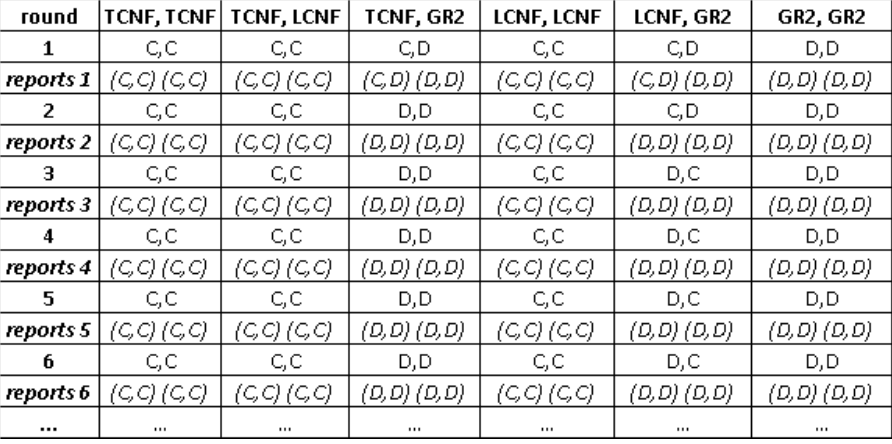
Patterns of interactions and reports for every possible pair of strategies in an exemplary population consisting of TCNF, LCNF and